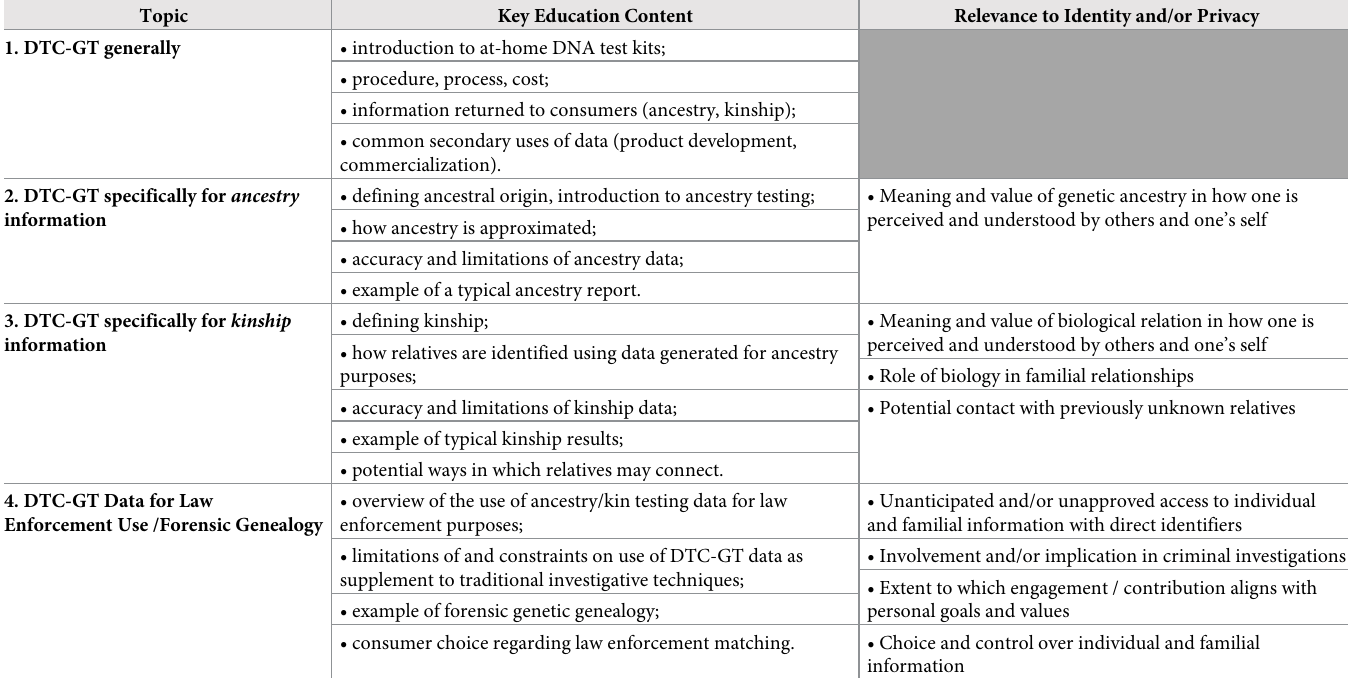
Table 2. Organization and relevance of discussion topics and key content of corresponding educational components.